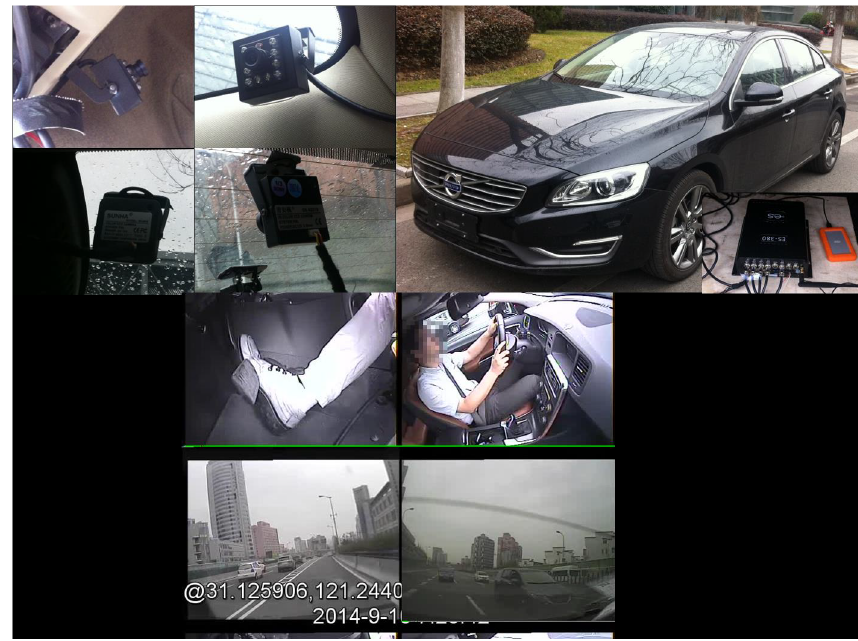
Figure 2. Naturalistic driving